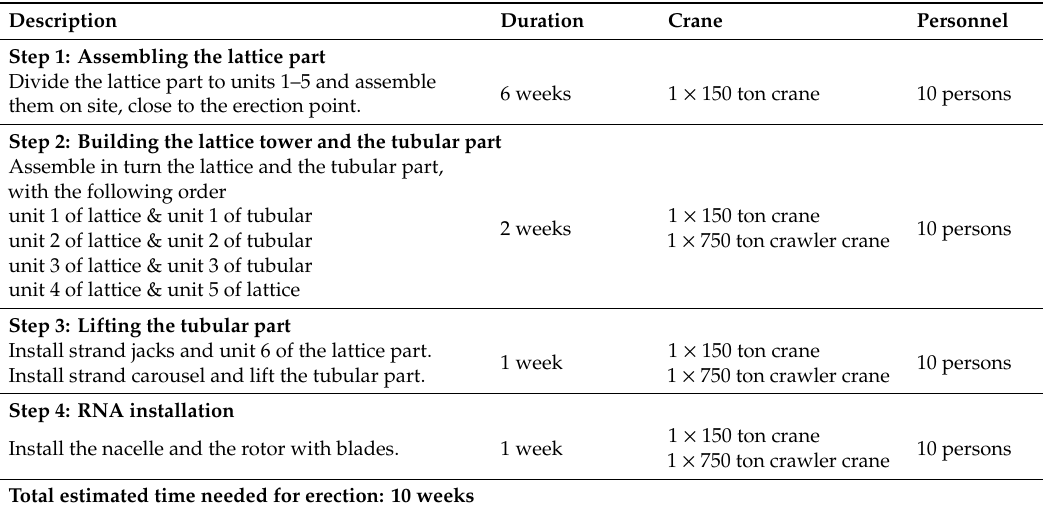
Table 4. Description of the erection process—time